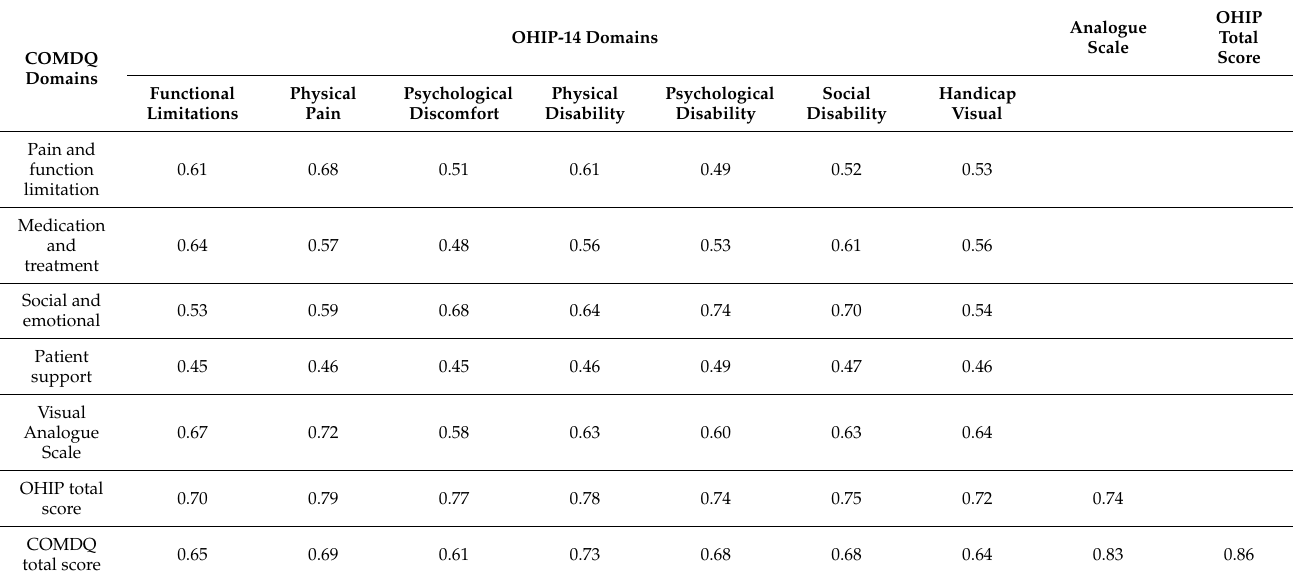
Table 3. Correlation between COMDQ, OHIP-14 and VAS.